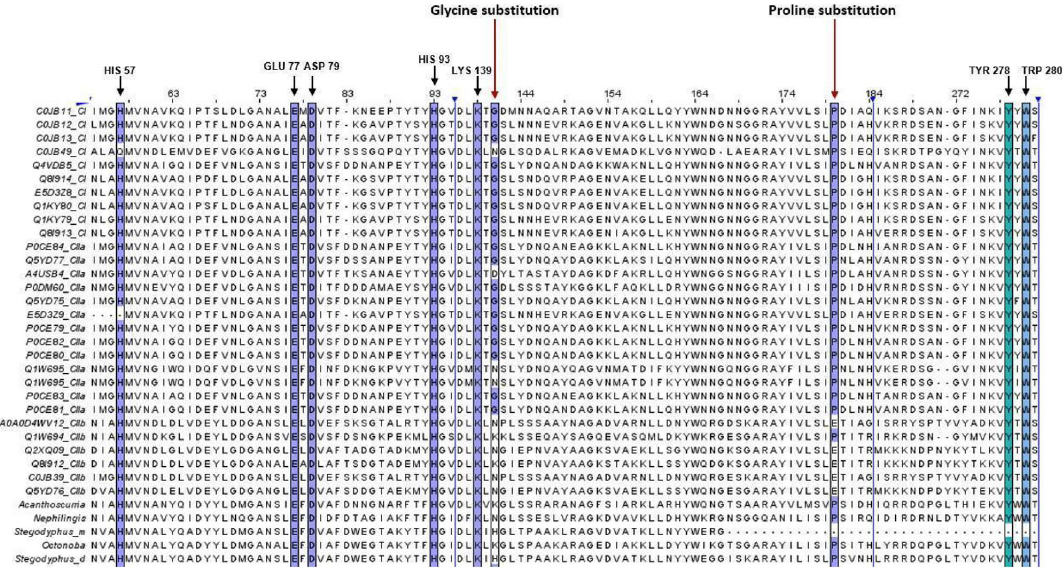
Figure 5. Spider venom and midgut SMaseD multiple sequence alignment, their classification by glycine and proline substitutions, and conservation of residues involved in catalysis. SMaseD of class I, class IIa and class IIb from L. venom gland were aligned against SMaseD from abdomen A. geniculata , midgut N. cruentata , digestive fluid S. mimosarum, and whole body S. dumicola and O. yesoensis in multiple sequence alignment (MUSCLE software) 80 , to classify the SMaseD found in midgut/digestive fluid of spiders. Most of the class I and class IIa SMaseD conserve the glycine and proline (purple highlighted and red arrowed indicated) residues, and class IIb SMaseD has a substitution in glycine/proline residues. As well, the conservation of histidines (His57 and His93), glutamic acid (Glu77), aspartic acid (Asp79), lysine (Lys139), tyrosine (Tyr278), and tryptophan (Trp280), involved in ion magnesium coordination and substrate recognition. Purple box: conserved histidine, glutamic acid, aspartic acid, lysine, glycine, and proline; Green box: conserved tyrosine; Blue box: conserved tryptophan. Midgut/digestive fluid SMaseD sequences only substitute the glycine residue (Gly141). Alignment was generated in Jalview (https:// www. jalvi ew. org 81